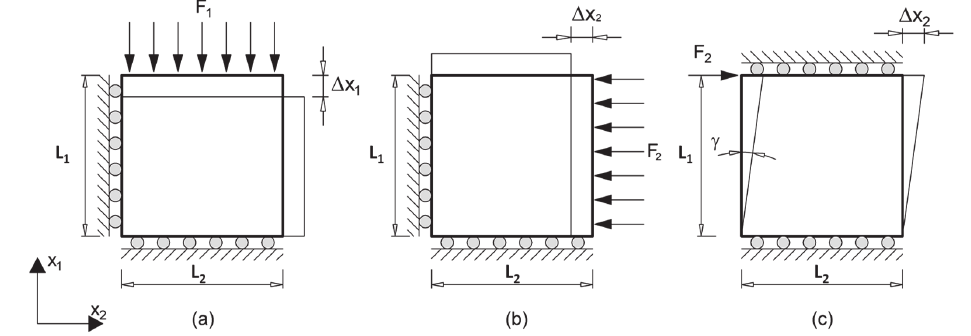
Figure 6: RVE mechanical tests: a) axial test along x 1 ; b) axial test along x 2 ; c)shear